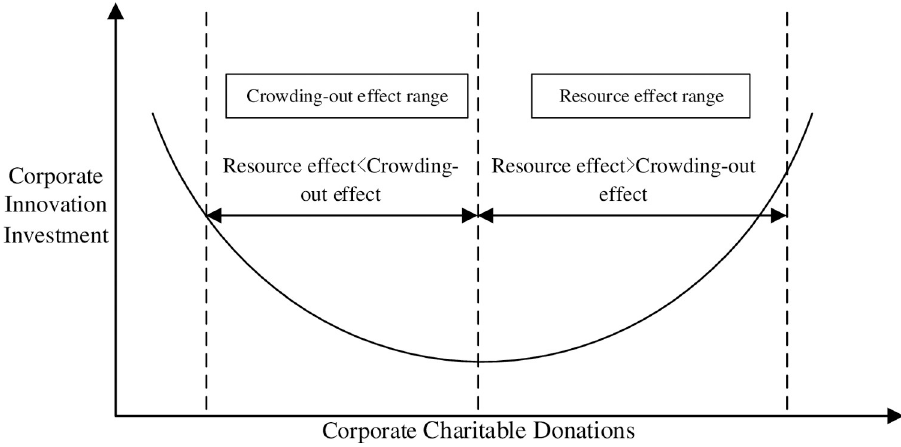
Fig 3. Mechanism of tool motivation oriented charitable donations on innovation